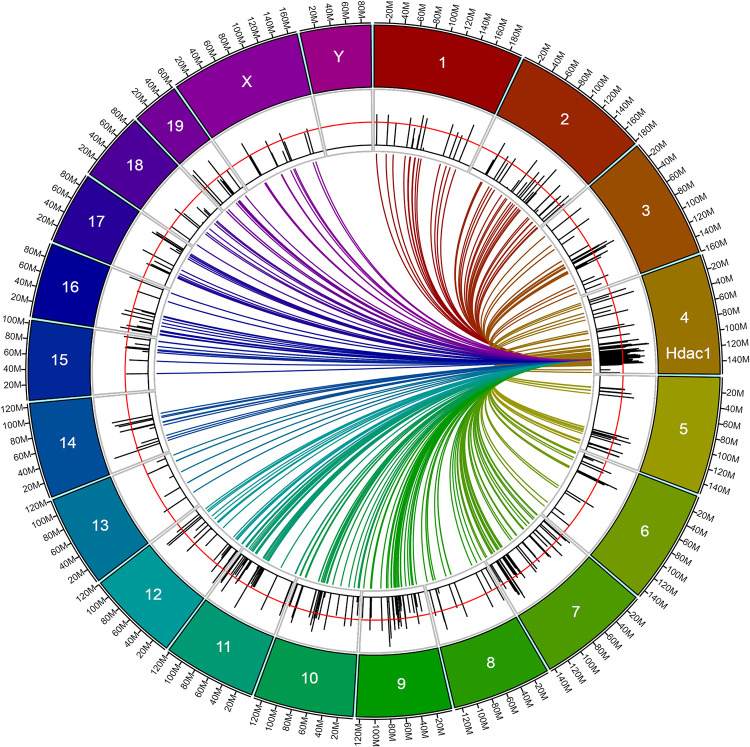
Circos plot of genes correlated to Hdac1 in the ethanol pretreatment group (nominal p<0.01; n=446).Colored lines connect Hdac1 to the location of the genes to which it is correlated. Black bars for each gene show the absolute value of the Pearson product-moment correlation coefficient (r) between the gene’s expression and AFT-Et (range of r values: <0.01 to 0.67). The red line over the black bars indicates the nominal p<0.05 cutoff for the correlation between gene expression and AFT-Et (r ≅ 0.31).